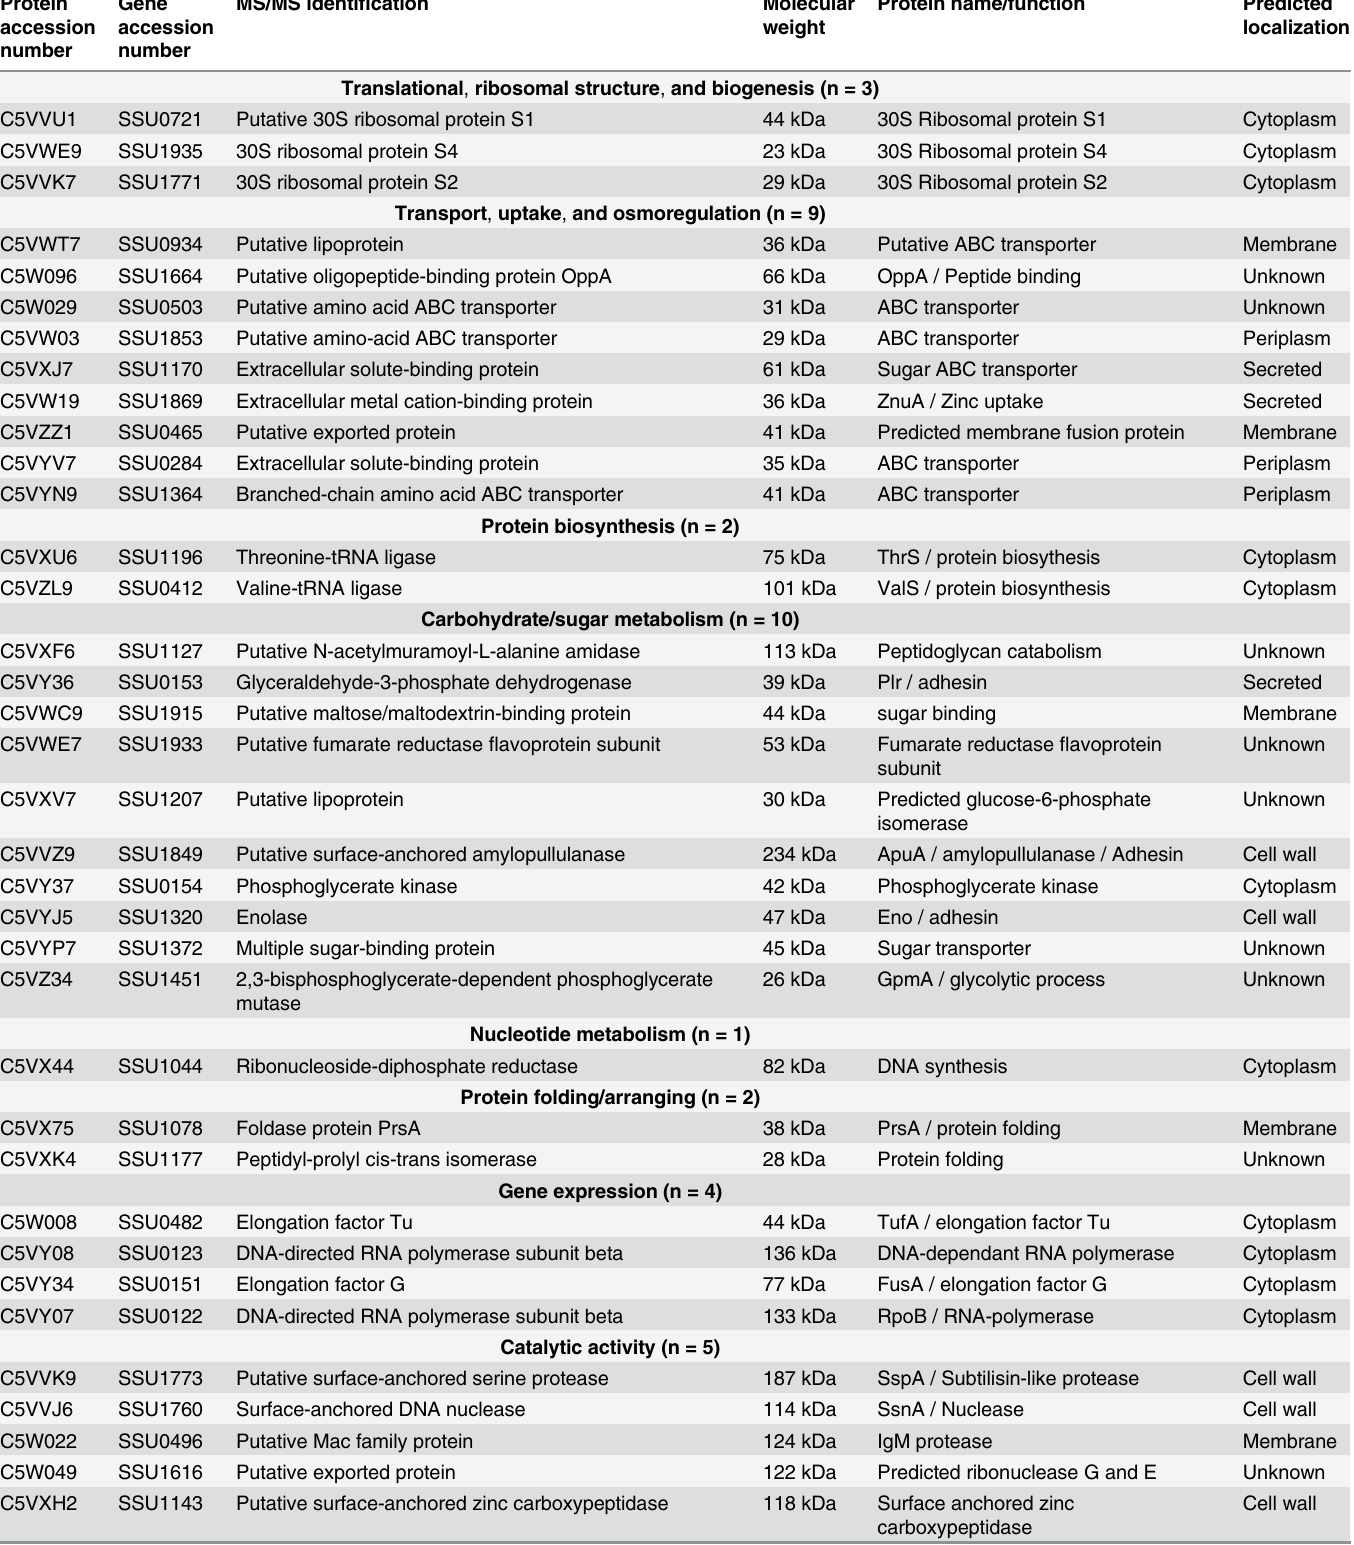
Table 1. Protein content of S . suis P1/7 membrane vesicles identified by ES MS/MS in order of abundance in each functional group. Protein